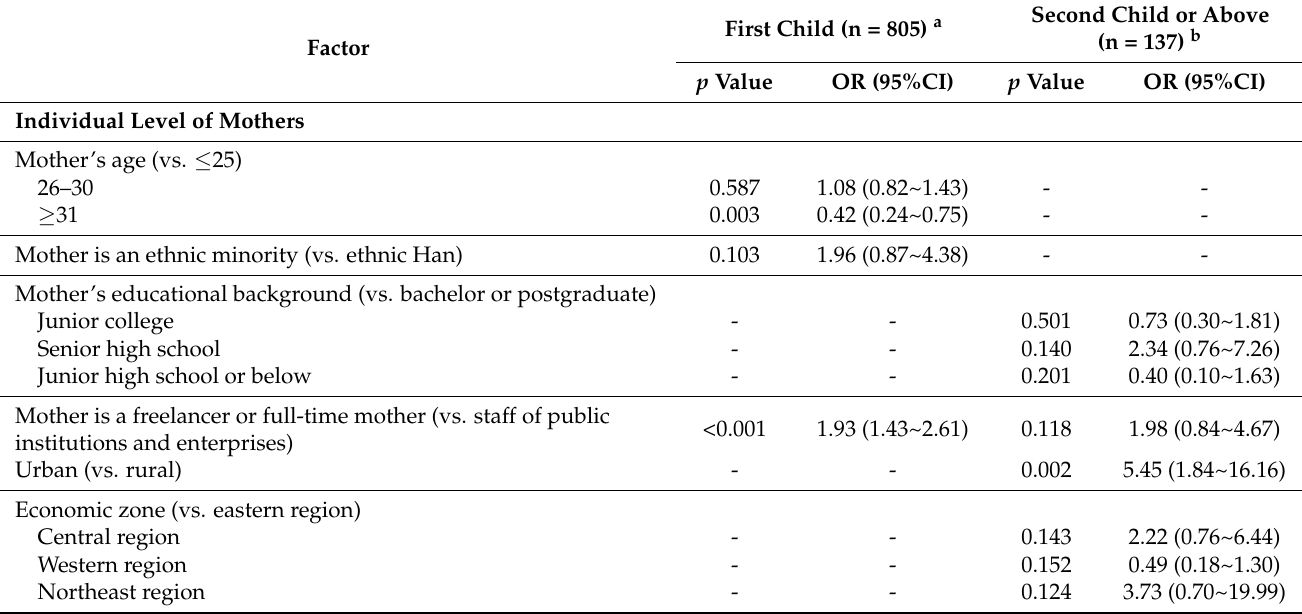
Table 4. Multivariable ordinal logistic regression of influencing factors of breastfeeding duration in different parities (subgroup